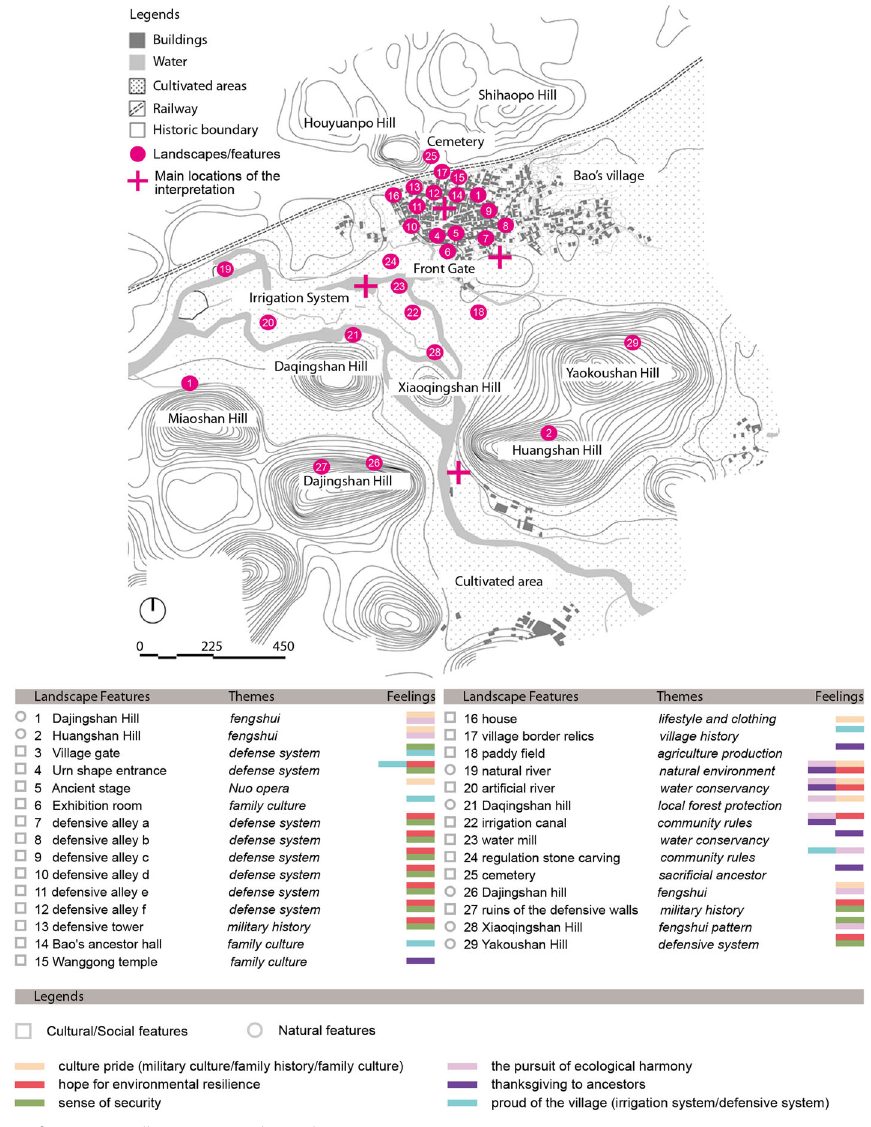
Fig. 4 A feeling map of Baojiatun Village (Source: the